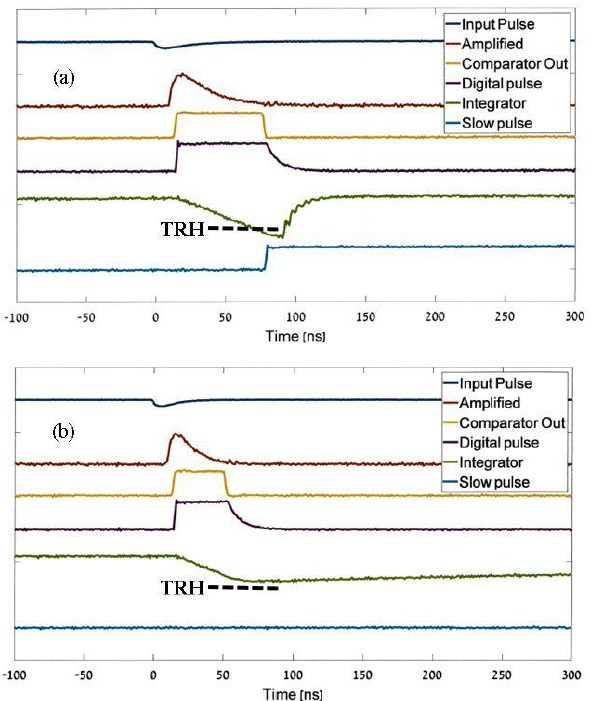
Fig. 4. Signal shape at different nodes, (a) for a slow pulse, (b) for a fast pulse.